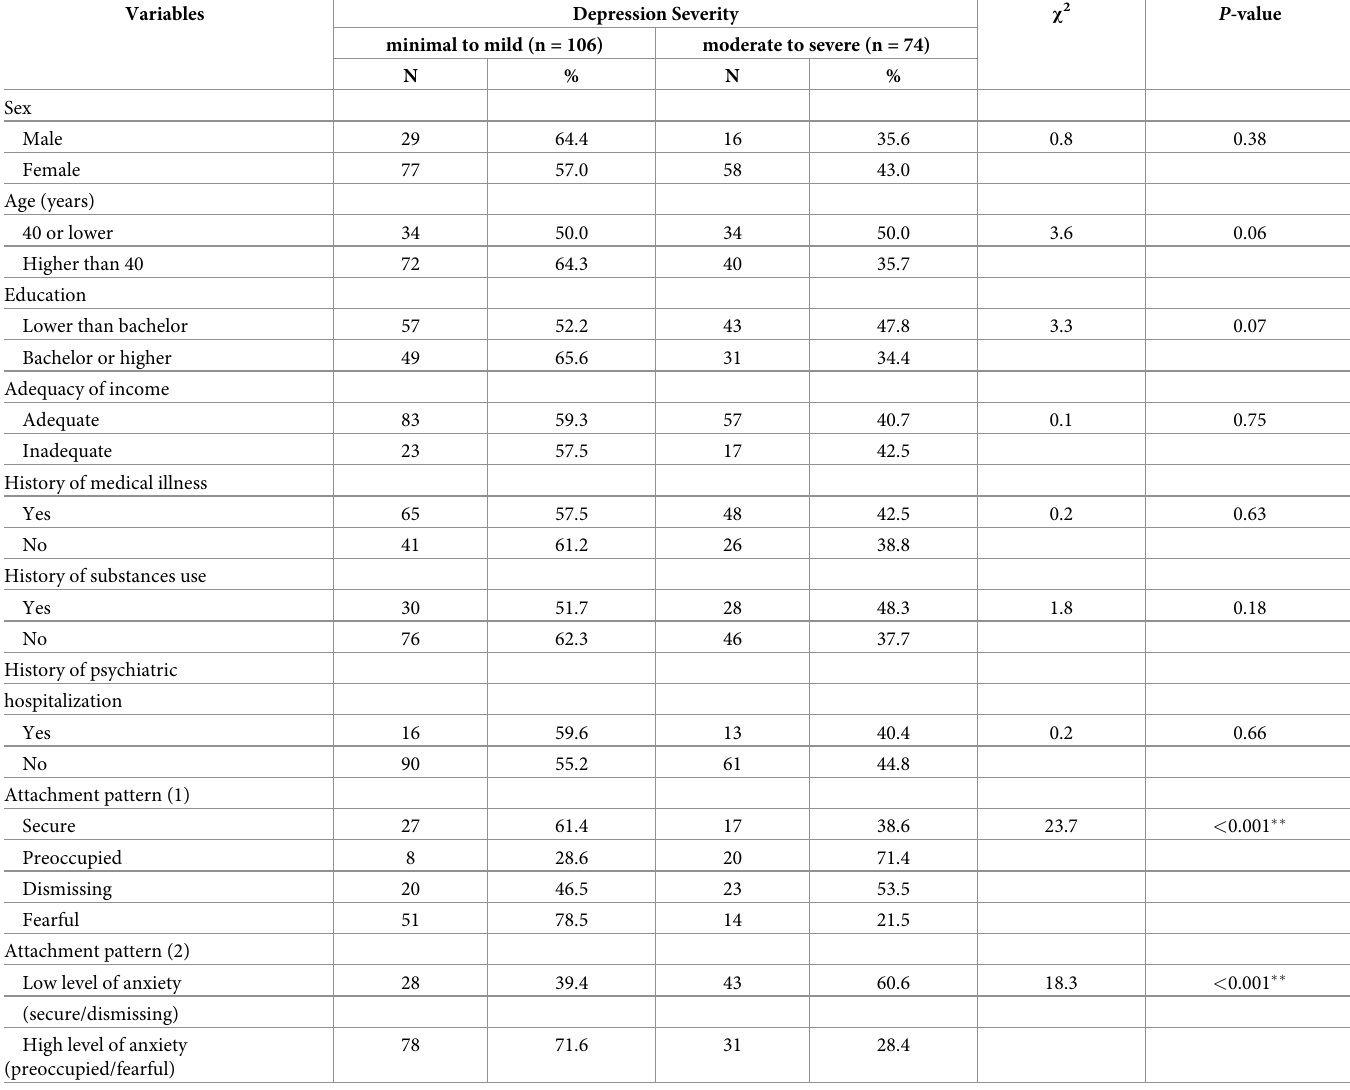
Table 4. Factors associated with depression severity.